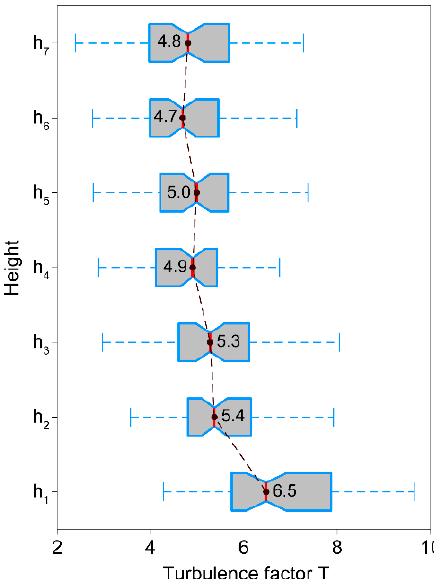
Figure 11. Turbulence factor T i,j at heights h 1 to h 7 for all intervals where mean momentum flux at canopy top M i,j > 1.0 m 2 / s 2 . The red vertical line indicates medians of T i,j . The whiskers include all values that lie within a distance from the first and third quartiles that is less than 1.5 times the interquartile range.